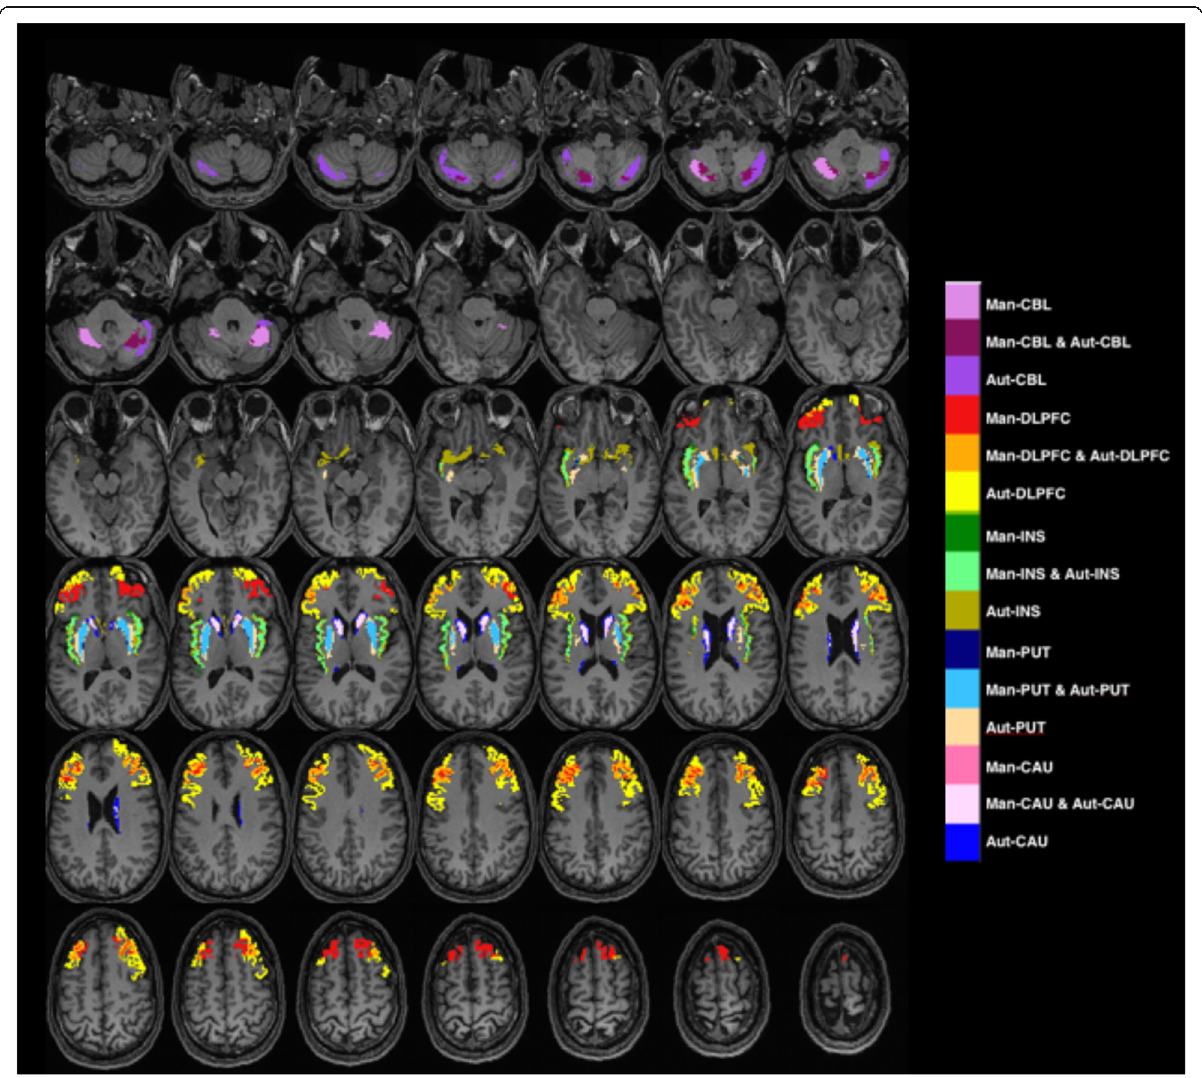
Fig 2 Color-coded voxels of the manual (Man) and automated (Aut) ROIs superimposed on the corresponding MR image of a healthy volunteer selected at random. ROIs generated manually are superimposed on those generated by FreeSurfer. CAU = caudate, PUT = putamen, DLPFC = dorsolateral prefrontal cortex, INS = insula, and CBL =